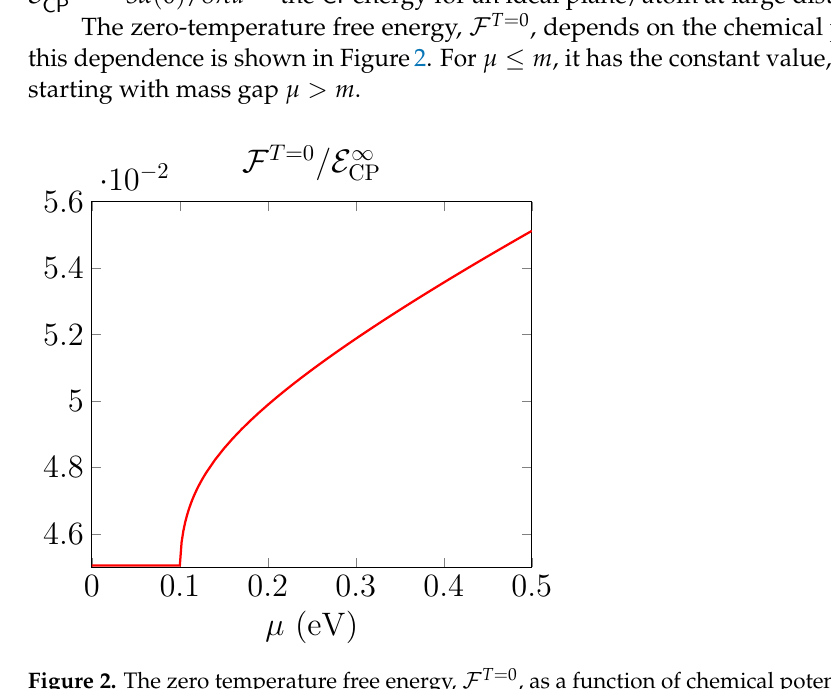
Figure 2. The zero temperature free energy,